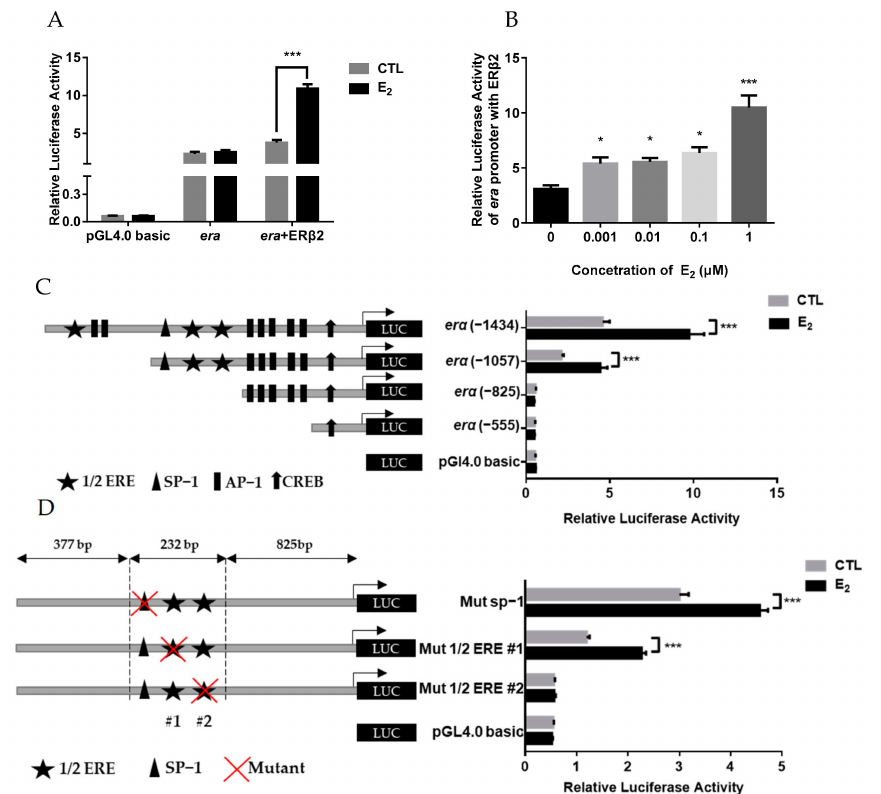
Figure 8. The luciferase activities of er α promoter in HEK293T cells. Cells in each well were co- transfected with 250 ng of promoter plasmid vector, 100 ng of ER β 2 expression vector, and 10 ng of pRL-TK vector (Promega). ( A ) Basal activities of er α promoter in transfected HEK293T cells. Transfected cells were treated with ethanol (CTL) or 1 µ M E 2 for 24 h. ( B ) The luciferase activities of er α promoter after different dose of E 2 treatment in the presence of ER β 2. ( C ) Deletion analysis of er α promoter. Left panel: schematic representation of er α promoter deletion constructs and the positions of the putative motifs. Right panel: the luciferase activities of corresponding er α promoter deletion constructs. ( D ) Mutation analysis of er α promoter. Left panel: schematic representation of er α promoter mutant constructs. Right panel: the luciferase activities of corresponding er α promoter mutant constructs. Transfected cells were treated with ethanol (CTL) or 1 µ M of E 2 for 24 h. Data were expressed as the mean ± SEM ( n = 4) of the relative luminescence activity from each promoter construct and analyzed by unpaired Student’s t -test ( A , C , D ) or one-way ANOVA followed by Tukey’s post-hoc test ( B ). * p < 0.05; *** p < 0.001 compared to the corresponding